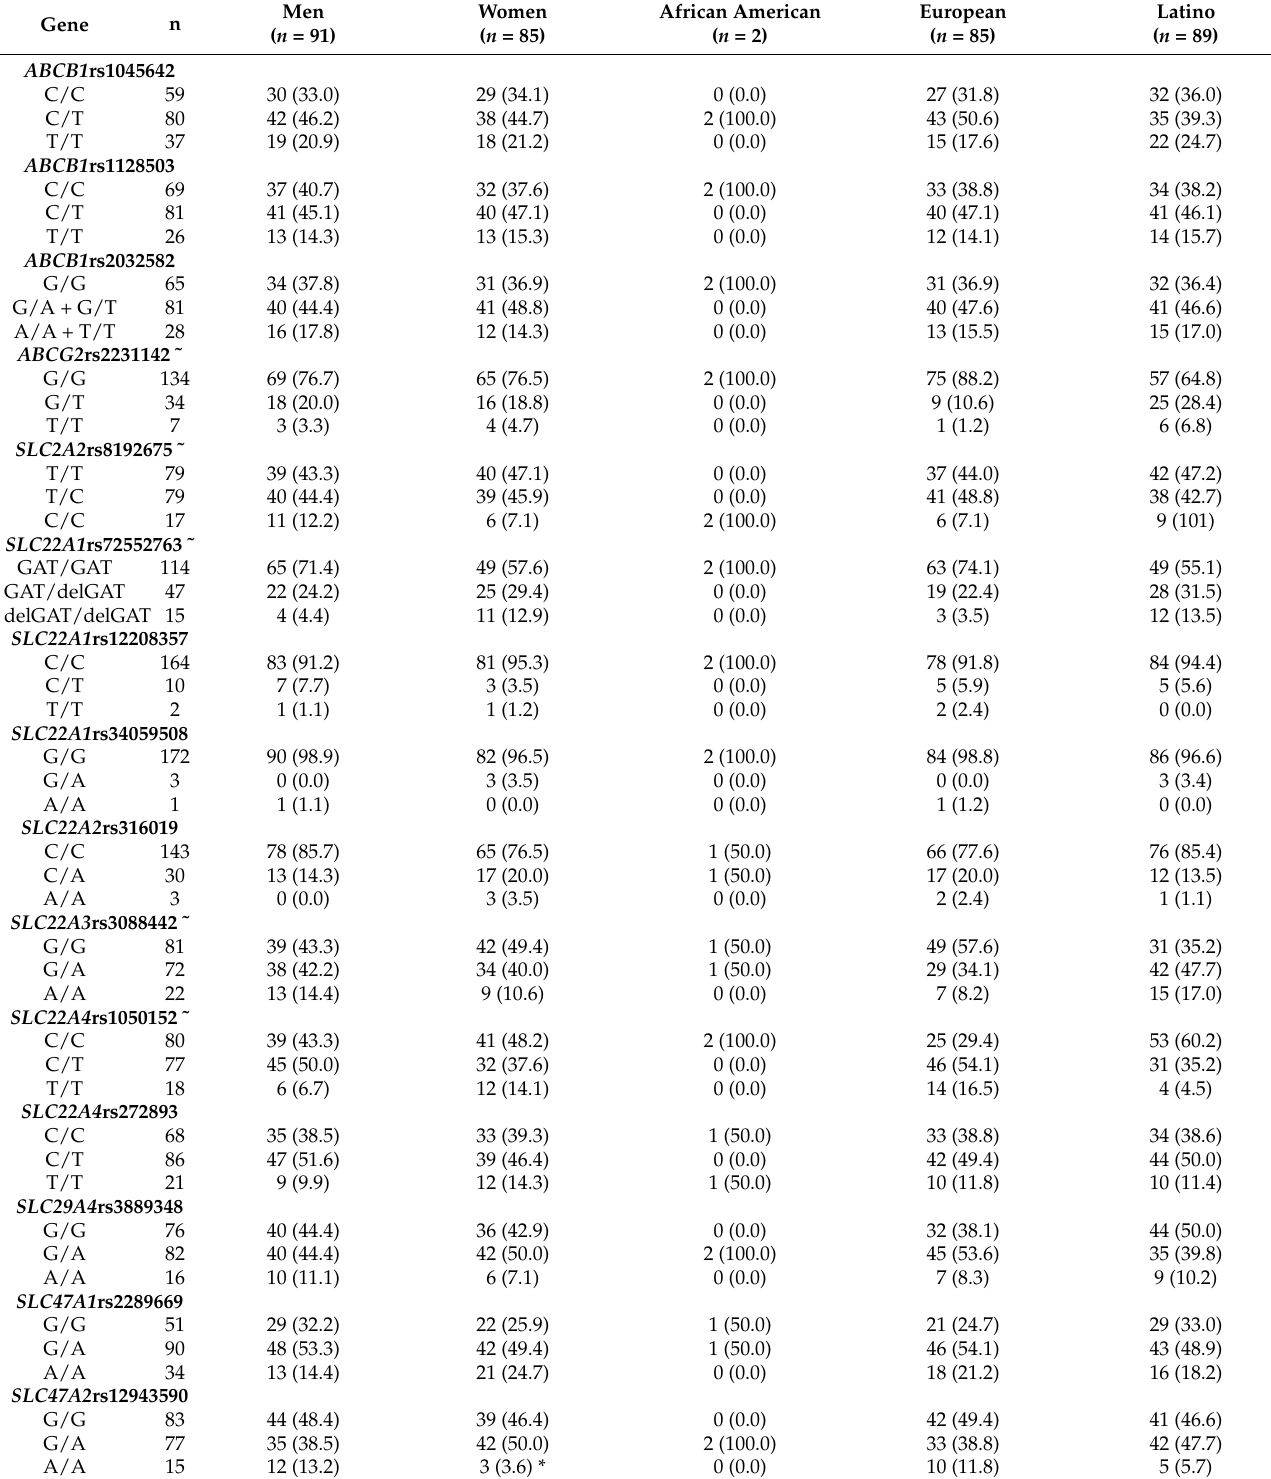
Table 1. Genotype frequencies of transporters in the study subjects, stratified by sex and ethnicity. Values are expressed as the number of individuals